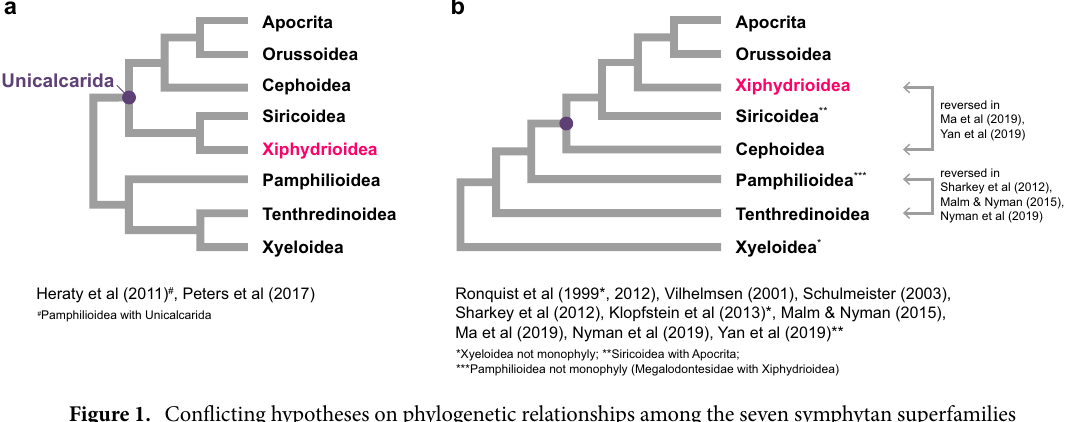
Figure 1. Conflicting hypotheses on phylogenetic relationships among the seven symphytan superfamilies except for Anaxyeloidea and the suborder Apocrita (see Fig. S1 for additional